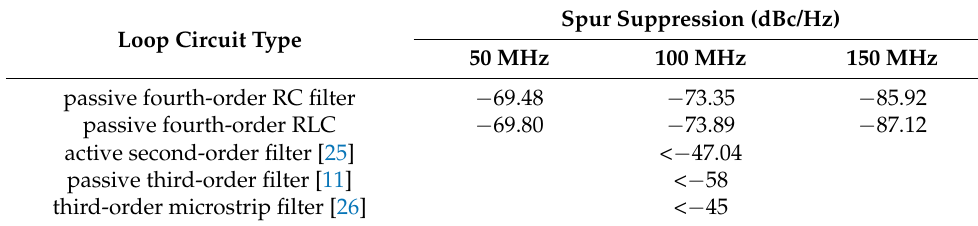
Table 8. Comparison of spur suppressions of different